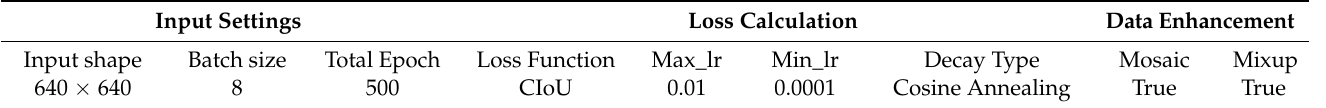
Table 4. The hyperparameters are set during the training of the proposed